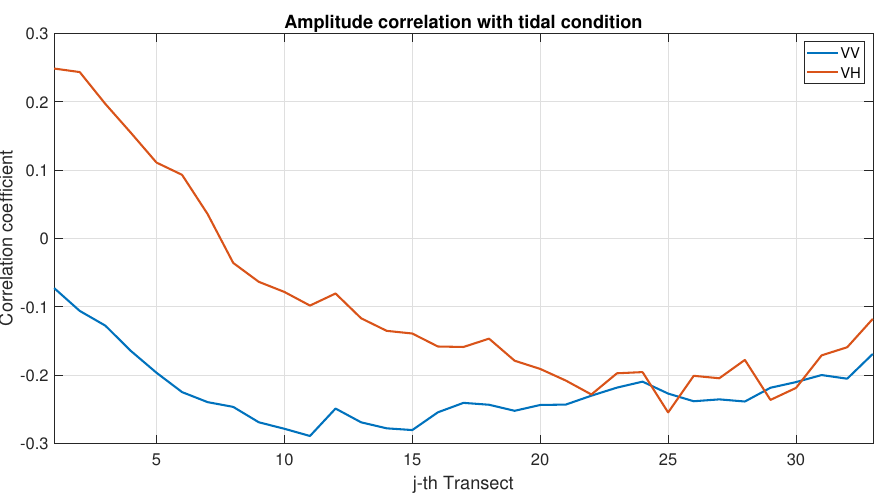
Figure 14. VH and VV amplitude correlation with tidal